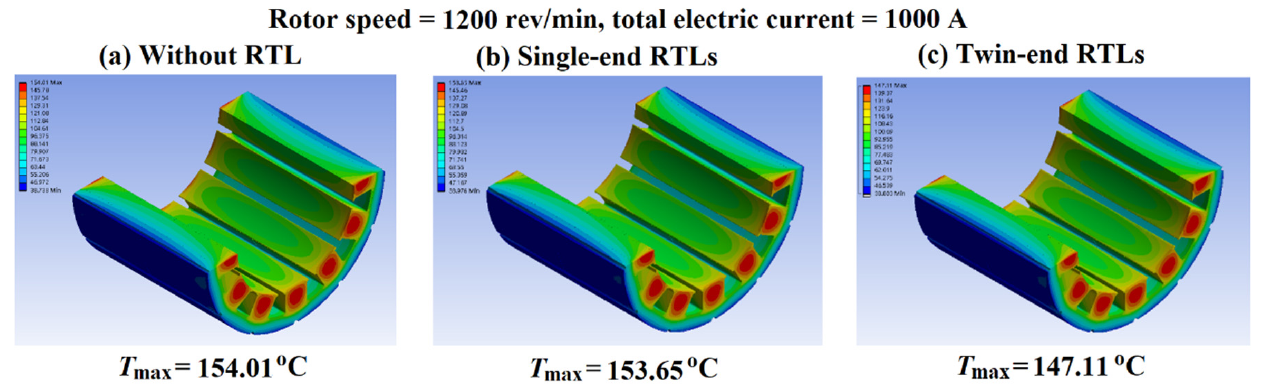
19 of 26 Figure 12. Thermal fields of the rotor in the PMSEMs ( a ) without RTL and with ( b ) single-end RTLs and ( c ) twin-end RTLs at T 0 operating condition. While the presence of RTLs significantly affects the levels and distribution patterns of temperature in the rotor of the PMSEMs, the augmented h ext,con and h inner,AC for the airflow in the air chamber that is enclosed by the rotor end-facet, the annular steel frame of stator, the rotating shaft, and the cold end-cover of the motor casing affect the temperature gra- dients in the coiled windings, leading to its consequential influences on the thermal fields of the windings. Figure 13 depicts the temperature distributions of the coiled windings in the PMSEMs (a) without RTL and with (b) single-end RTLs and (c) twin-end RTLs at the T 0 operating condition. As compared in Figure 13, the patterns of temperature distribution of the coiled windings in the PMSEMs with and without the RTLs are similar. The hot zone is centered in the winding core with higher temperatures at the two axial ends in contact with the hot annular steel frame of the stator. The T max in each coiled winding remains higher than the maximum temperature in the rotor of each PMSEM owing to much higher copper loss than other losses, as shown in Table 2. The augmented h inner,AC in